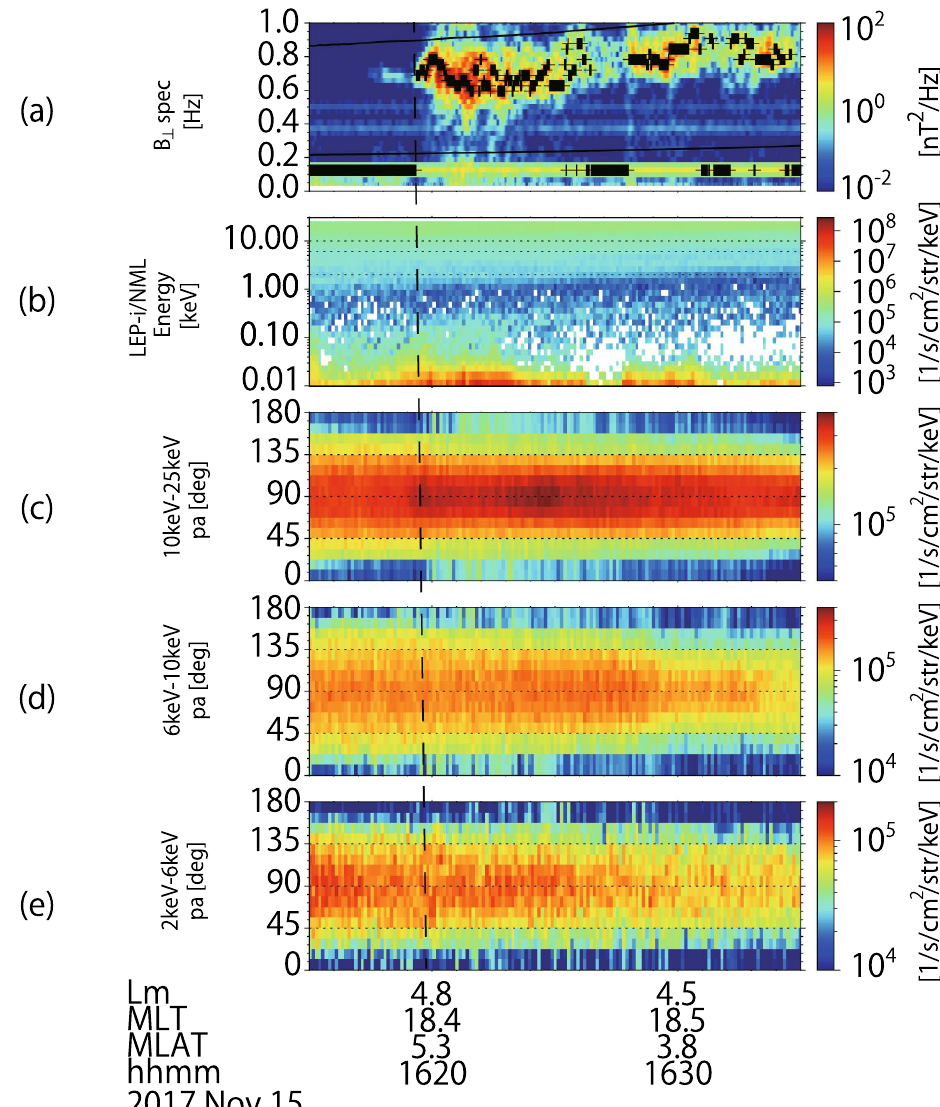
Figure 2. ( a ) Dynamic spectrum of magnetic field in the perpendicular direction to the ambient magnetic field. The black solid lines indicate the helium (upper) and oxygen (lower) cyclotron frequency. ( b ) Energy-time diagram of the proton flux observed by LEP-i. The horizontal dotted lines indicate the energy at 2 keV, 6 keV, 10 keV, and 25 keV, respectively. ( c – e ) Pitch angle distributions of the proton flux with energy range 10–25 keV, 6–10 keV, and 2–6 keV, respectively. The satellite positions are described in the bottom of the figures; Lm is McIlwain L-shell of the field line, MLT is the magnetic local time, MLAT is the magnetic latitudes from the magnetic equator along the field line, and hhmm shows the universal time on Nov. 15, 2017. (Created by using IDL 8.8 https:// www. l3har risge ospat ial. com/ Softw are- Techn ology/